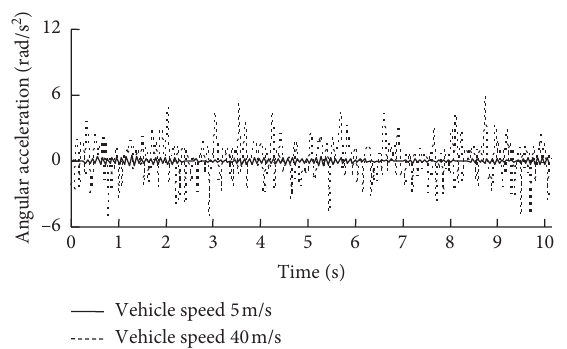
Figure 16: The time-history curves of pitching vibration accel- erations of the vehicle body.